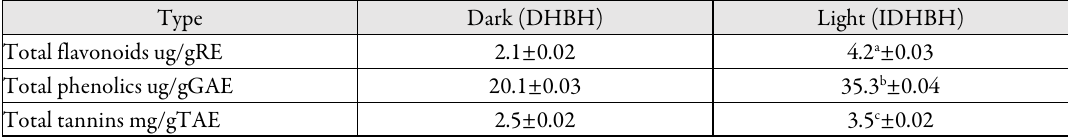
Table1. Phytochemical analysis of Eucalyptus globulus essential dark and light oil